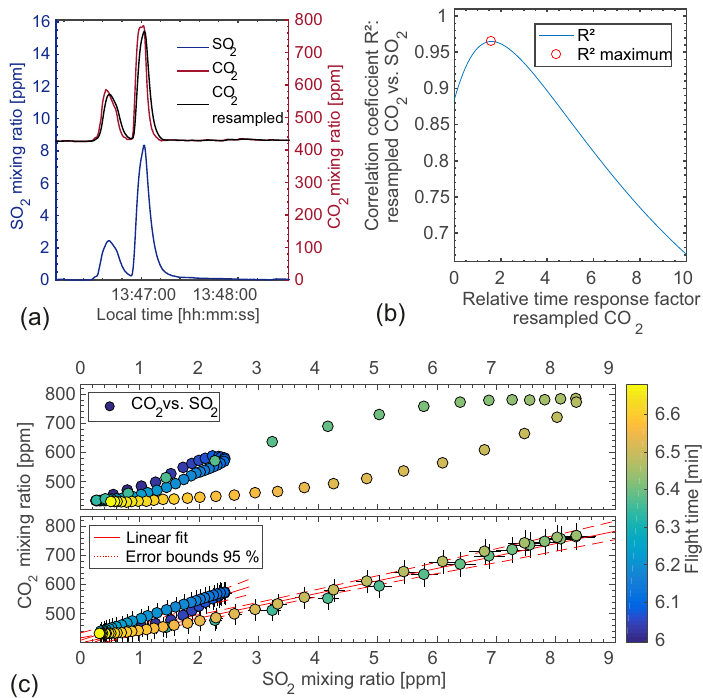
Figure 5. (a) Example of time series for mixing ratios of SO 2 and CO 2 (original data in red, resampled data in black), showing discrete gas masses at Stromboli volcano (first flight on 5 April 2016), (b) Correlation plot for the determination of the relative response-time factor for the CO 2 gas sensor with a maximum at a relative response-time factor of 1.7, (c) CO 2 over SO 2 mixing ratios, showing the outcome of the resampling of the fast CO 2 with a relative response-time factor of 1.7 (lower plot), linear regression results CO 2 / SO 2 ratios of 64 ± 16 the first peak and 42 ± 4 for the